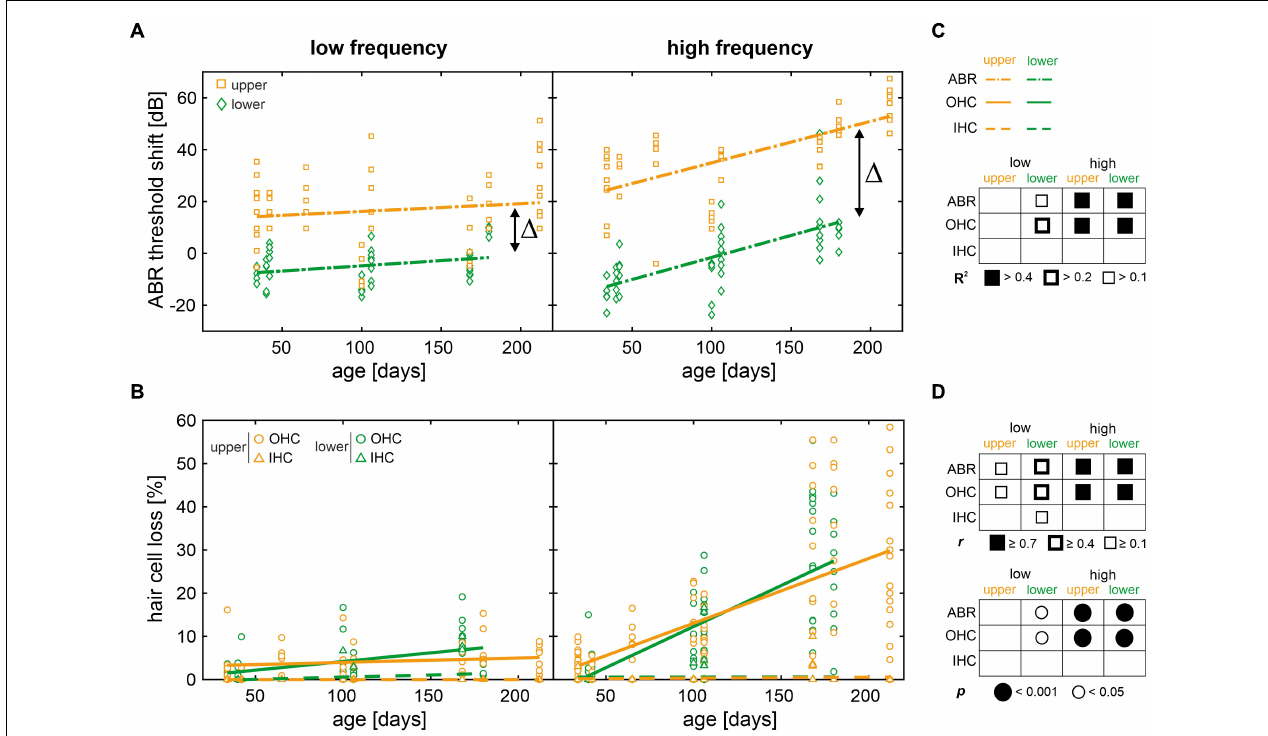
FIGURE 6 | Scatterplots of auditory brainstem response (ABR) threshold shifts and hair cell loss as a function of age with regression and correlation analysis. (A) Individual ABR threshold shifts over age for mice in the lower (green diamonds) and upper (orange squares) quartiles, in the low- ( ≤ 8 kHz) and high-frequency ( > 8 kHz) range, respectively. ABR threshold shifts were calculated for each mouse by subtracting the mean threshold of the reference cohort at juvenile age (see Figure 2 ) from each given threshold, at each given frequency. Fitted linear regression models (dash-dotted lines) are shown for mice in the lower (green) and upper (orange) quartiles, respectively. (cid:49) indicates the difference of intercepts between models for mice in the lower and upper quartiles, for each frequency range. (B) Individual outer and inner hair cell loss (OHC as circles and IHC as triangles, respectively) over age for mice in the lower (green) and upper (orange) quartiles, in the low- and high-frequency range, respectively. Fitted linear regression models for OHC loss (solid lines) and for IHC loss (dashed lines) are shown for mice in the lower (green) and upper (orange) quartiles, respectively. (C) Graphical representation of the coefficient of determination ( R 2 ) ranges of the linear regression models for each measure and for each condition. (D) Graphical representation of correlation coefficients (Pearson’s r , upper table) and corresponding significance values ( p , lower table) for each measure and for each condition.